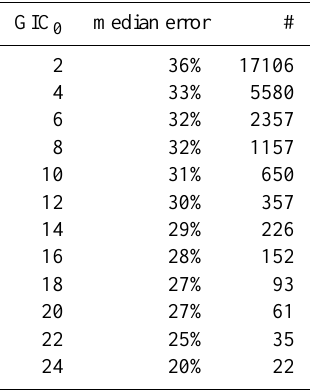
Table 8. As Table 7, but the magnetic field at Nurmij¨arvi was used to calculate the electric field.